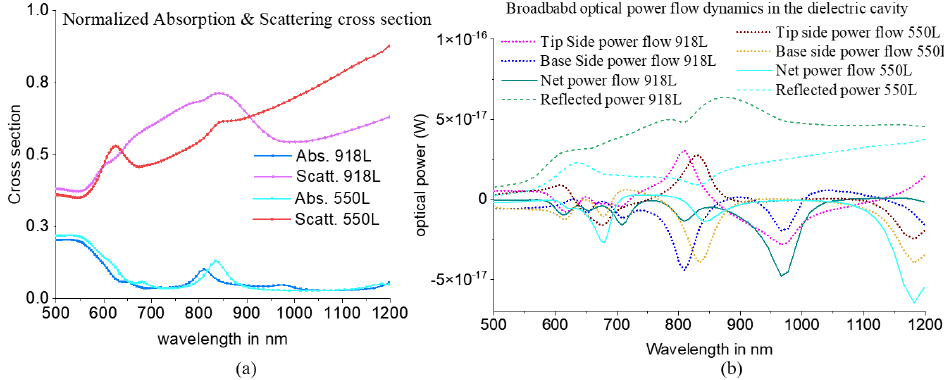
Figure 5. ( a ) The normalized scattering and absorption cross-sections; ( b ) the power flows of the SPP waves. Negative values indicate that power was flowing toward the negative x direction (tip) and positive values indicate that power was flowing toward the positive x direction (base), as well as the reflected power (positive z direction).